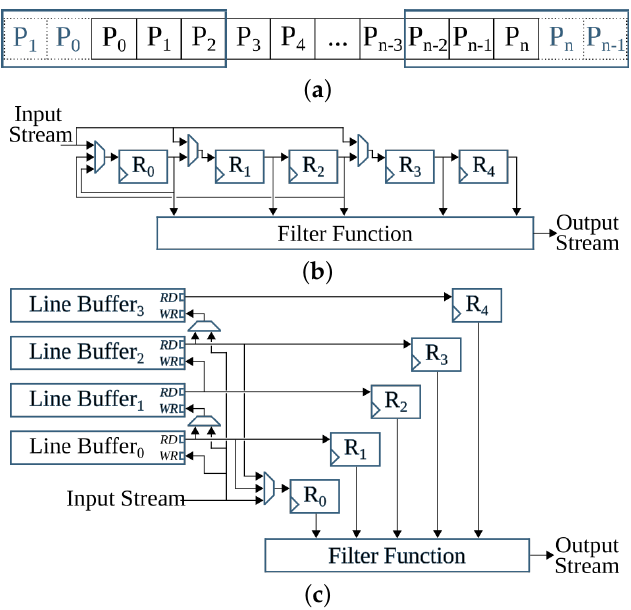
Figure 18. Border handling for a 5 × 5 separable filter ( a ) reflection of border pixels ( b ) SIPO shift registers for horizontal computation with border reflection logic ( c ) line buffers and window for vertical computation with border reflection